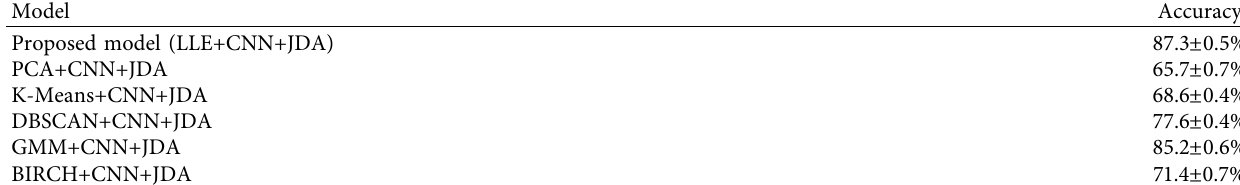
Table 4: Accuracy of diagnosis with different data filtering methods.